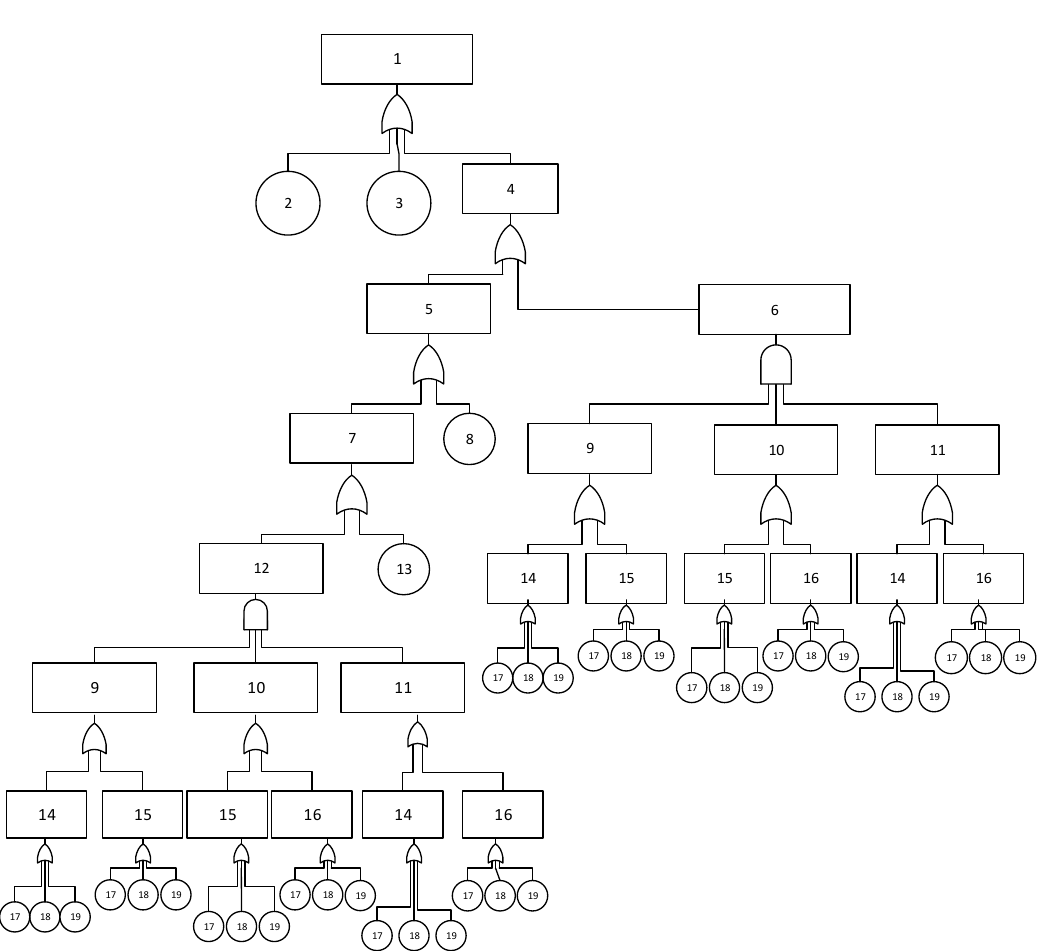
Figure A2. Fault tree of reactor scram failure activated by mass flow rate signal. Note: 1 = reactor fail to scram. 2 = control rods insertion fail (B1). 3 = contact 6 system fail (B2). 4 = no signal. 5 = no scram manually. 6 = no scram from automatic system. 7 = the operator does not receive an alarm. 8 = operator fail (B7). 9 = detector system of JAA-01 CL 811 and 821 fail. 10 = detector system of JAA-01 CL 831 and 821 fail. 11 = detector system of JAA-01 CL 811 and 831 fail. 12 = detector system fail. 13 = alarm fail